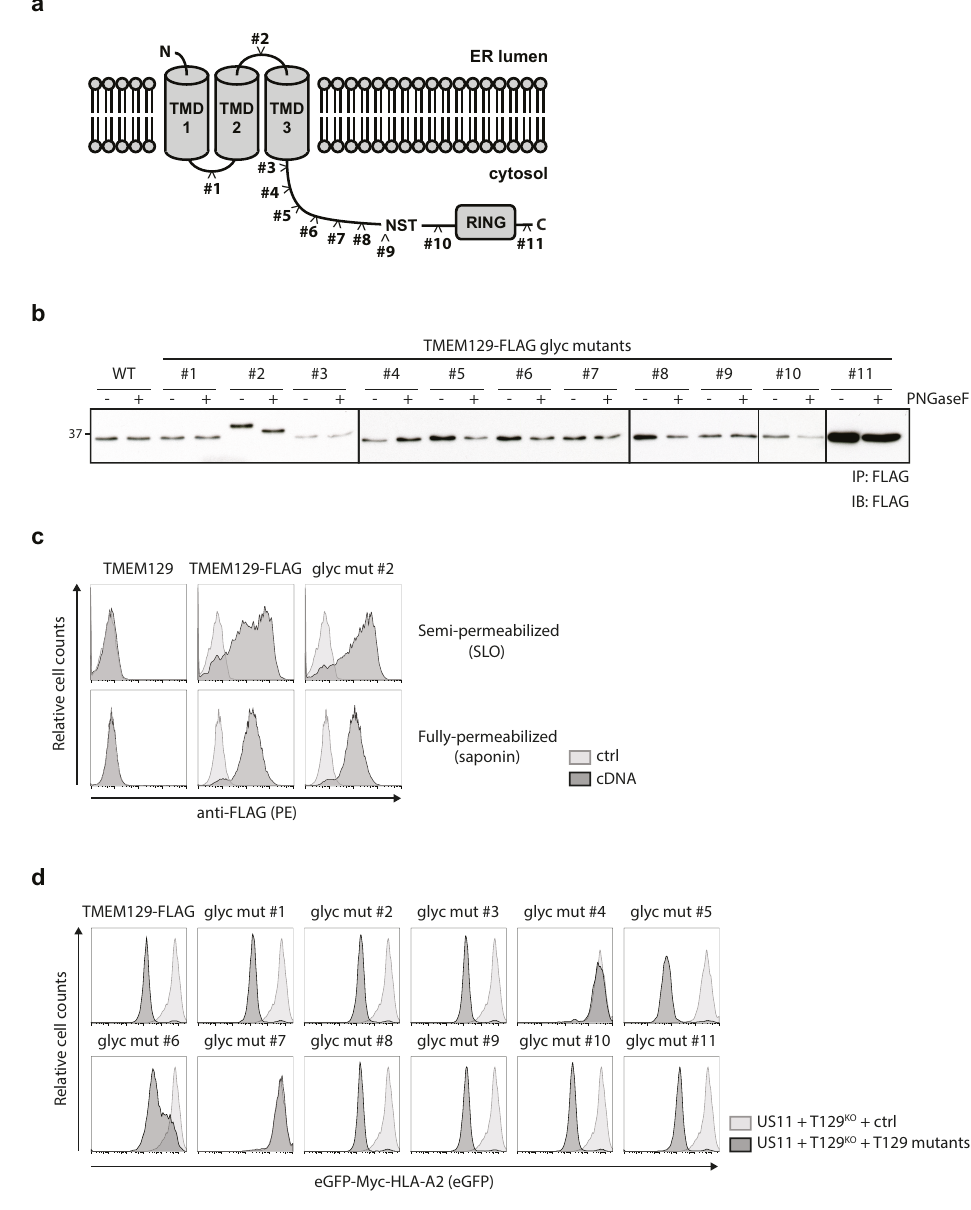
Figure 4. TMEM129 is a tri ‐ spanning ER membrane protein. ( a ) Glycosylation motif insertion mutants of TMEM129 (#1–11) were generated as indicated; ( b ) The loop between transmembrane domain (TMD) 2 and TMD3 is located inside the ER lumen. TMEM129 ‐ FLAG glycosylation mutants were expressed in U937 cells, and subjected to immunoprecipitation using anti ‐ FLAG ‐ coupled beads. Eluted proteins were then subjected to PNGase F digestion. After PNGase F was removed, TMEM129 ‐ FLAG mutants were detected using a FLAG ‐ reactive antibody. This experiment was performed two times, of which one representative experiment is shown; ( c ) The C ‐ terminal orientation of glycosylation mutant #2 is unaltered. U937 cells expressing TMEM129 ‐ FLAG or glycosylation mutant #2 were semi ‐ permeabilized using SLO, or fully ‐ permeabilized using saponin. The respective C ‐ termini were detected using a FLAG ‐ reactive antibody, after which the flow cytometric analysis was performed; ( d ) Most, but not all, glycosylation insertions did not affect TMEM129 activity. TMEM129-FLAG glycosylation mutants were expressed in TMEM129-null U937 cells, co-expressing eGFP-Myc-HLA-A2 and HCMV US11. Flow cytometric analysis was performed to assess the total levels of eGFP-Myc-HLA-A2. Experiments were performed three times, of which one representative experiment is